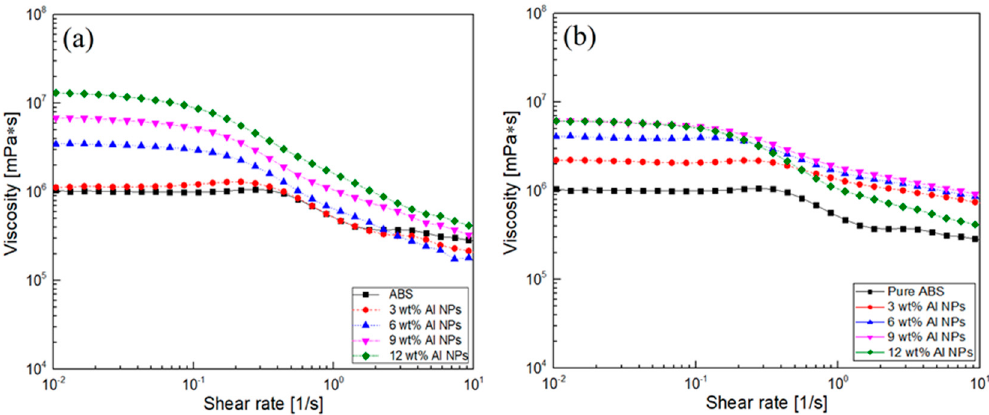
Figure 4. Viscosity of ABS/Al: ( a ) 20 nm and ( b ) 40 nm nanoparticle composites.